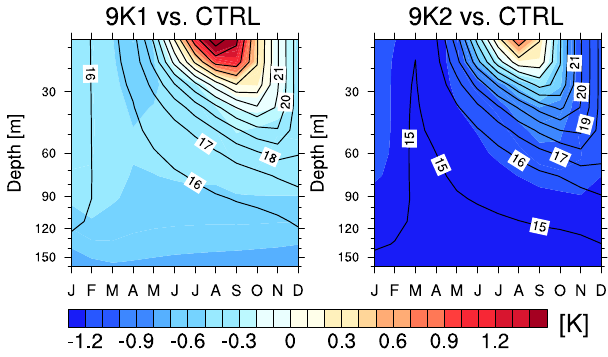
Fig. 10. Anomalies in monthly seasonal cycle of upper ocean tem- perature averaged over the Eastern Mediterranean, 9K1 vs. CTRL (left) and 9K2 vs. CTRL (right); isolines represent the absolute val- ues in ◦ C for 9K1 (left) and 9K2